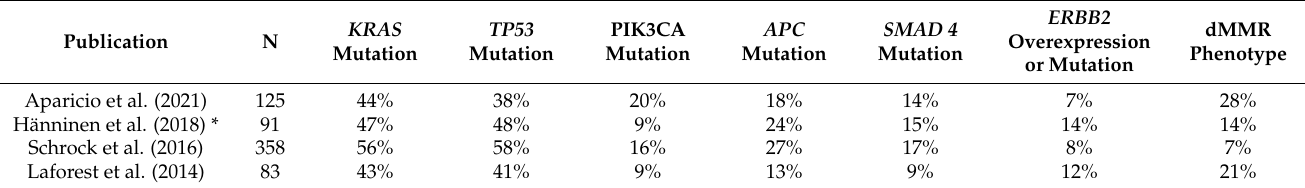
Table 1. Main molecular alterations observed in small bowel